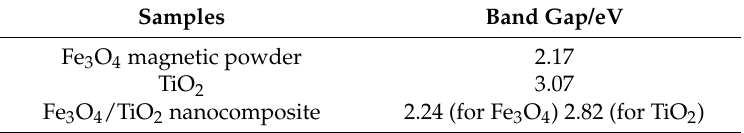
Table 1. The band gap of Fe 3 O 4 magnetic powder, TiO 2 and Fe 3 O 4 /TiO 2 nanocomposite.